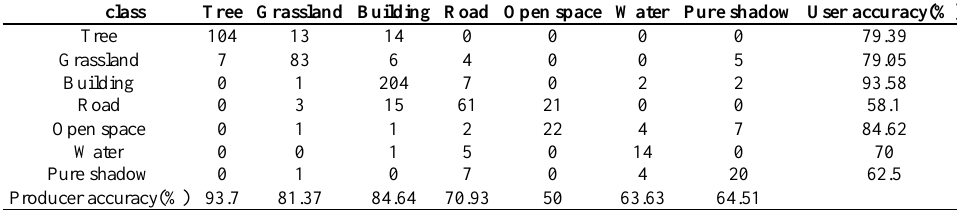
Table 3. The confusion matrix of classification on region B (Hierarchical method)